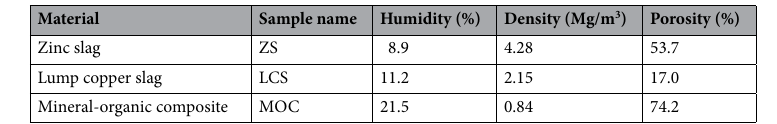
Table 1. Physical properties of test